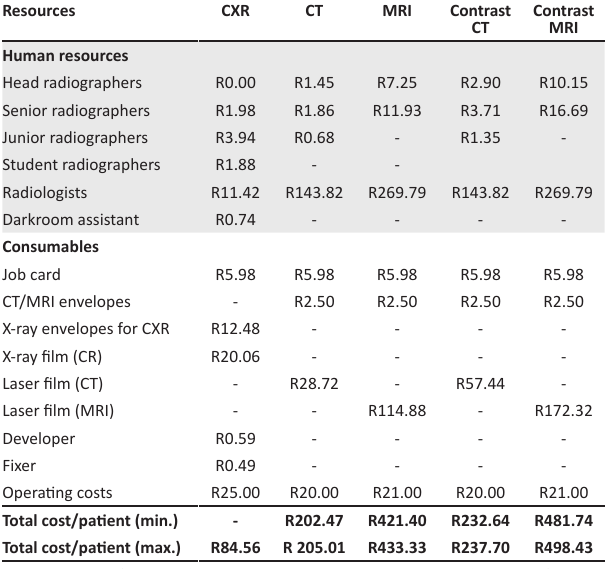
TABLE 5: Imaging costs for conventional radiography.